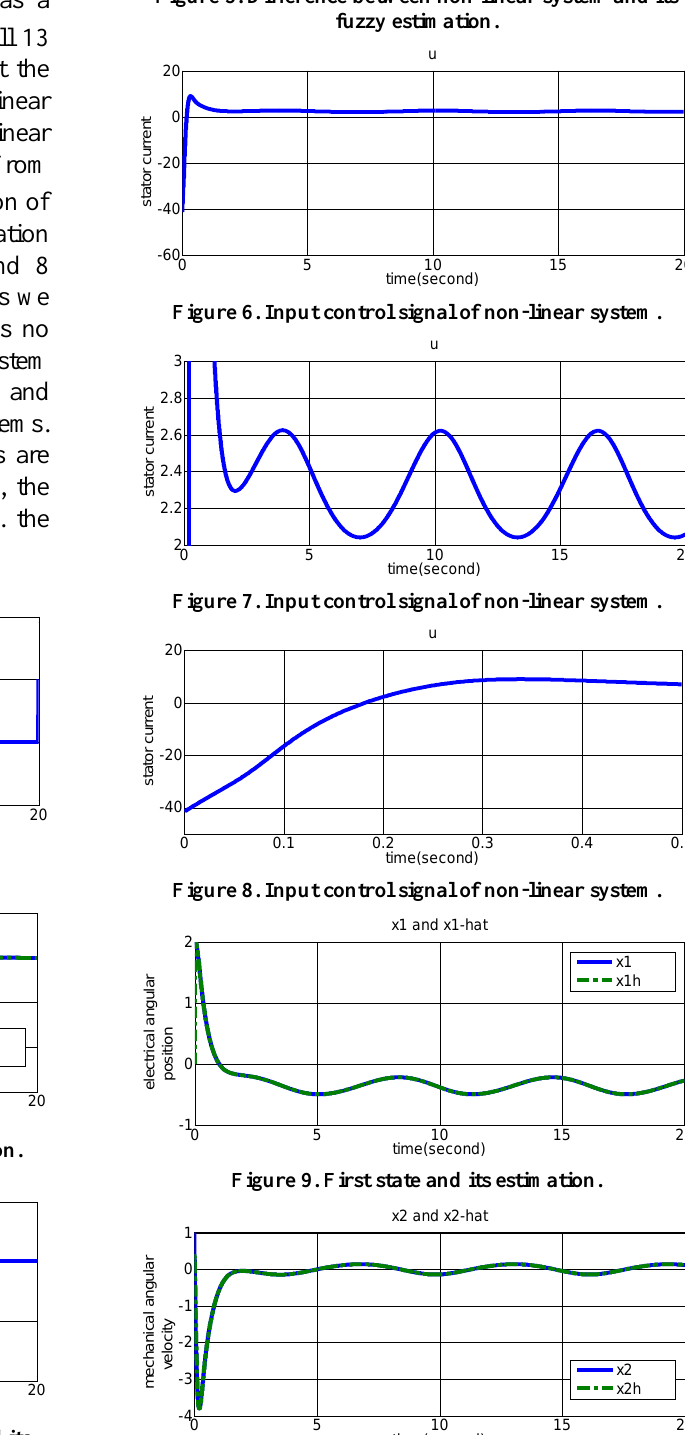
Figure 4. Difference between non-linear system and its fuzzy estimation.